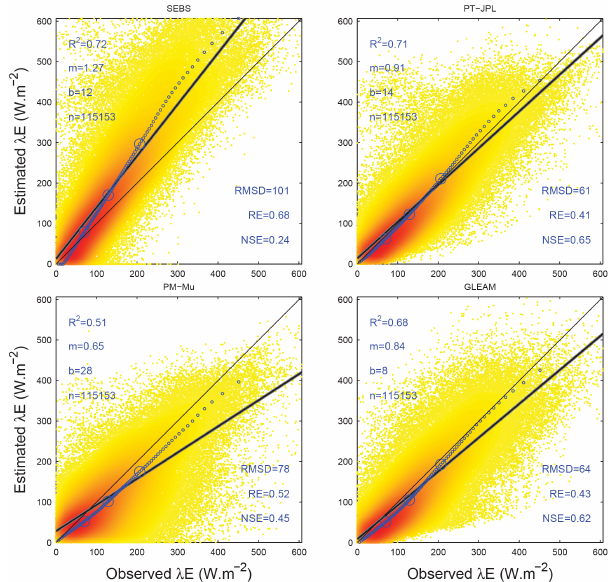
Figure 3. Scatter plots of observed vs. simulated evaporation for grid-based data. Colors show the frequency of values from high (red) to low (yellow). The thick black line is the linear regression and the thin line is the 1:1 line. The series of small circles show the percentile increments of data from the 1st to 99th, with large circles denoting the 25th, 50th and 75th percentiles. The statistics shown on the graphs are coefficient of determination ( R 2 ), slope ( m ), y inter- cept ( b ), number of data records ( n ), the root mean squared differ- ence (RMSD), relative error (RE) and the Nash–Sutcliffe efficiency